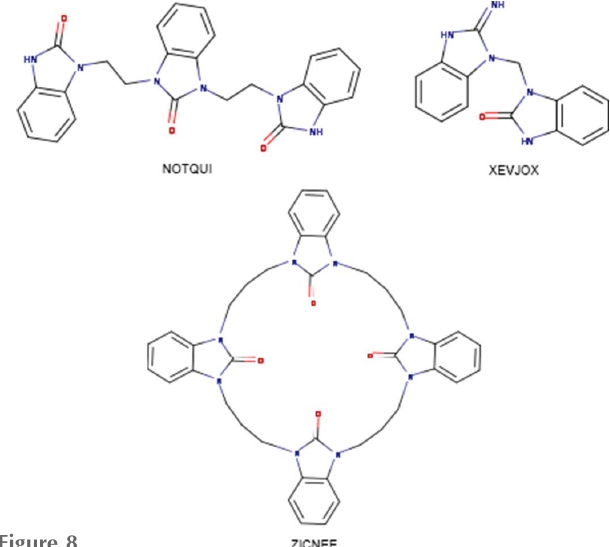
Figure 8 NOTQUI, XEVJOX and ZICNEE.